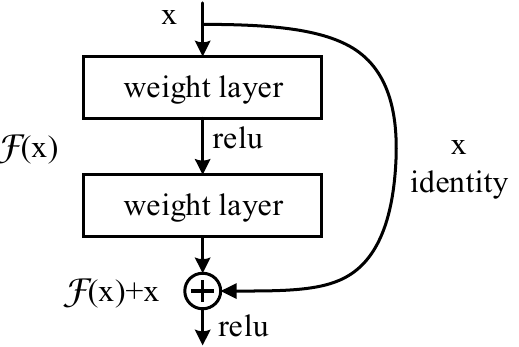
Figure 1. Residual Figure 1. Residual structure.